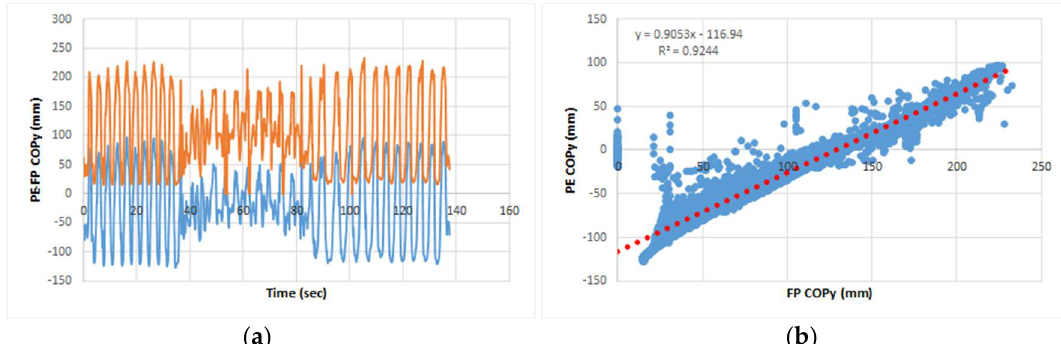
Figure 3. ( a ) COPy of PE (orange) and FP (blue) against time (one participant); ( b ) linear regression fit function for COPy (mm) FP vs COPy (mm) PE (one participant).